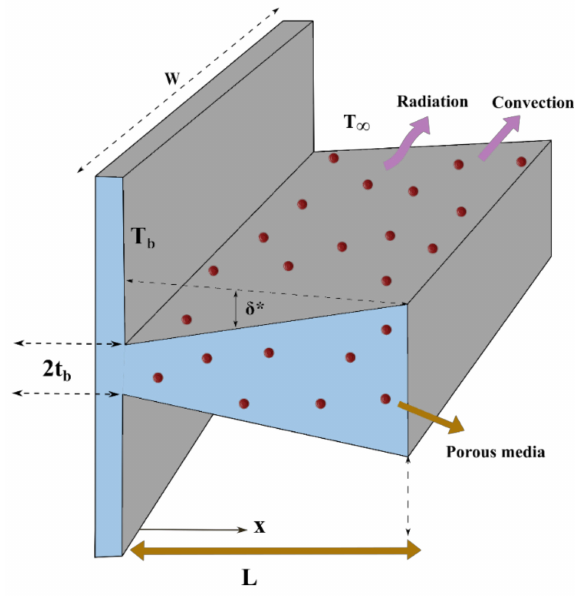
Figure 1. Physical model of a dovetail